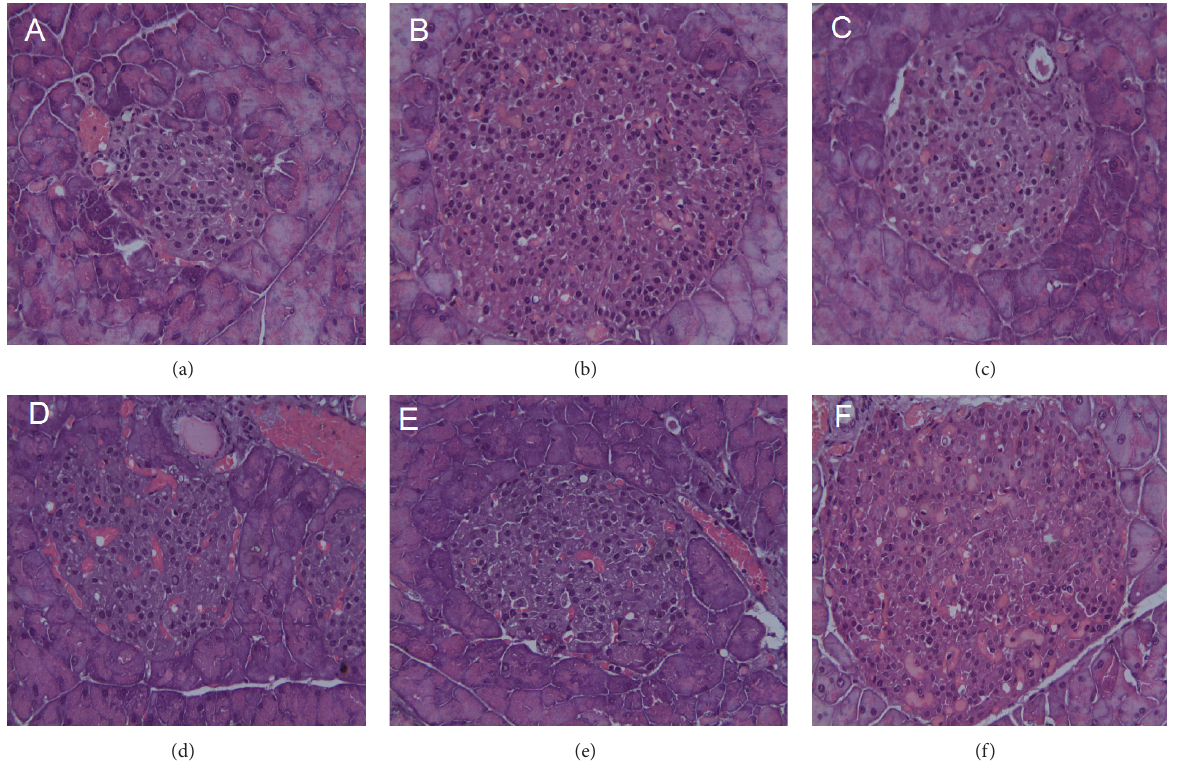
Figure 10: Pathological examination of pancreatic islets in db/db mice. (a) Pancreatic islet from a normal mouse. (b) Pancreatic islet from db/db mouse with no treatment shows severe degranulation of most 𝛽 -cells in this islet. (c) Pancreatic islet from db/db mouse treated with metformin. (d), (e), and (f) Pancreatic islet from db/db mouse treated with TNTL at the dose of 3.6 g, 1.8 and 0.9 g/kg b.w.,